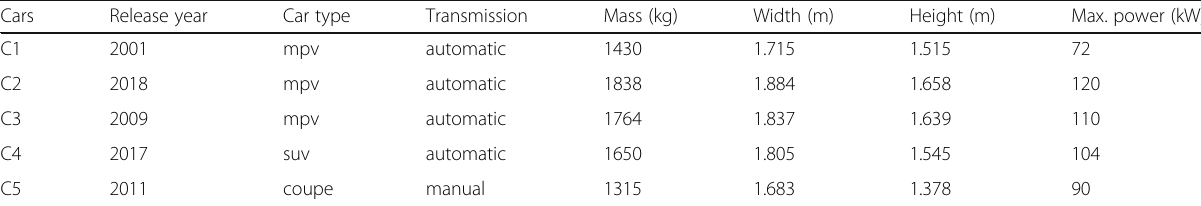
Table 1 Specifications of the test vehicles